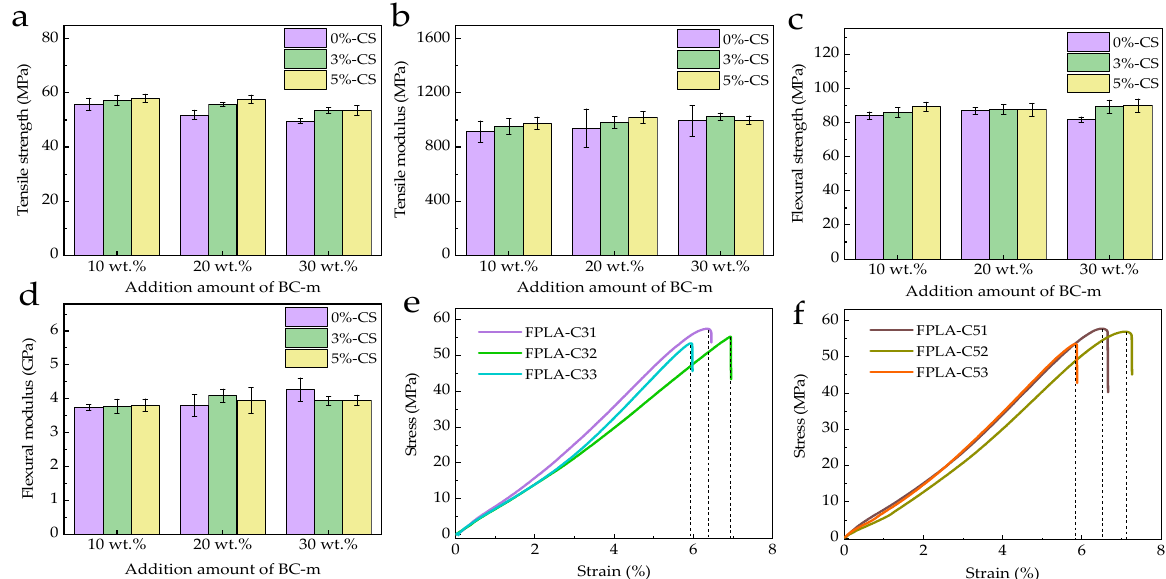
Figure 6. Diffraction patterns of PLA and FPLA composites.